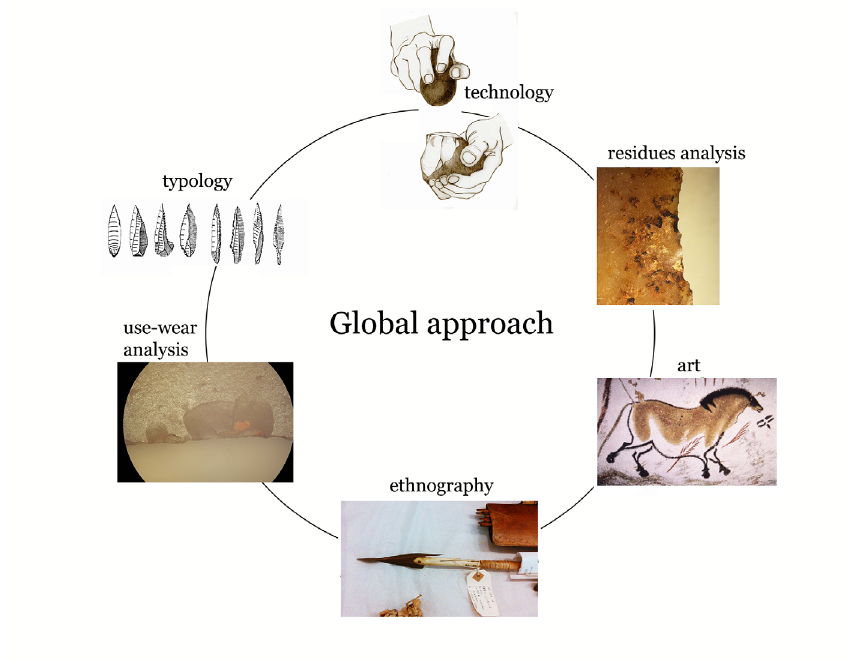
Figure 2. Methodological “global” approach proposed for the analysis of the hunting weapons.